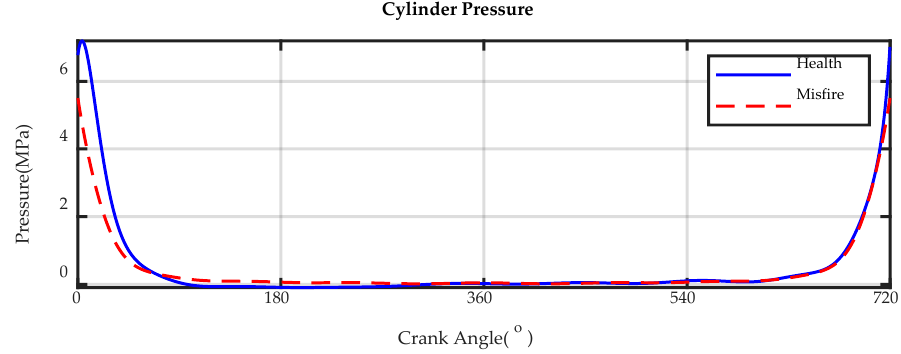
Figure 5. Cylinder pressure signals at health and misfire conditions.